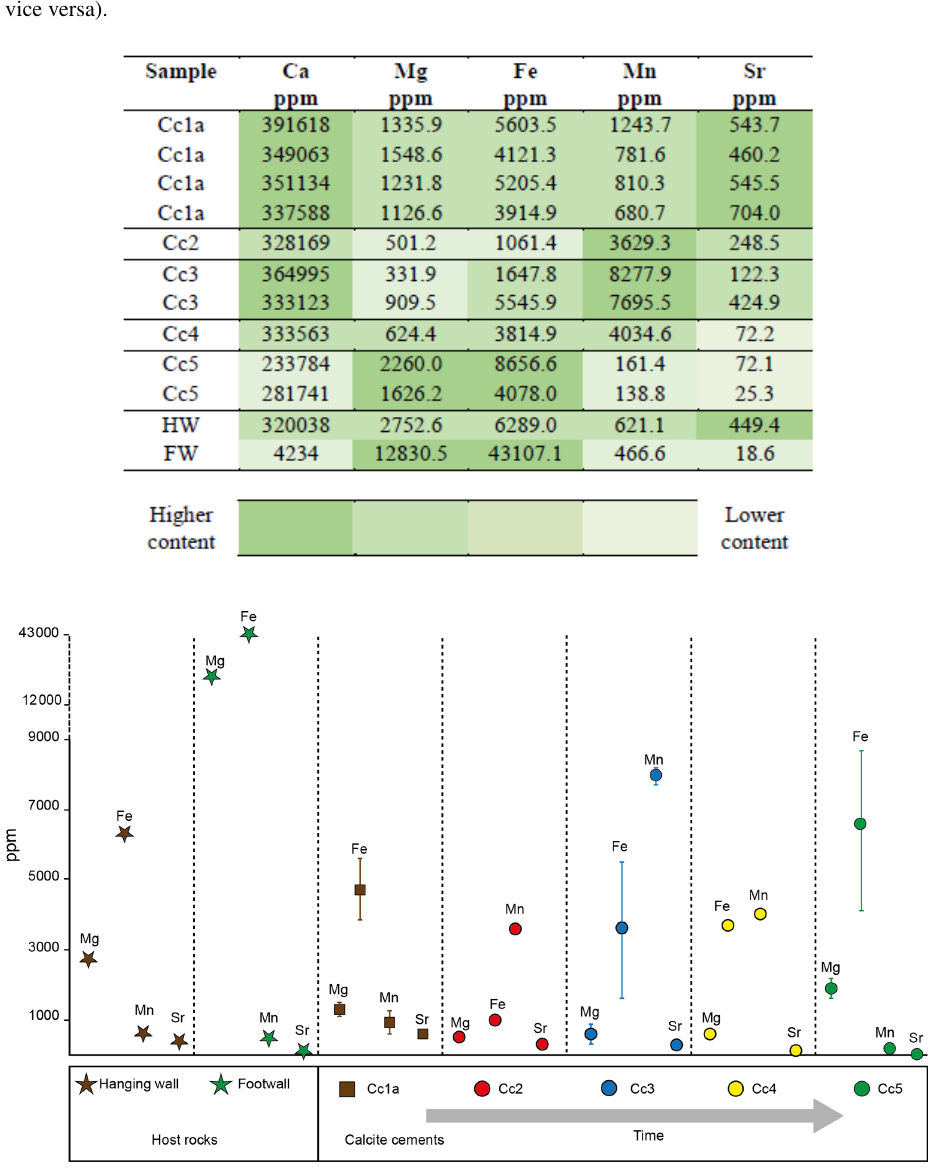
Figure 12. Elemental composition (including Mg, Fe, Mn, and Sr) in parts per million of the different calcite cements and host rocks. Bars indicate maximum, minimum, and average